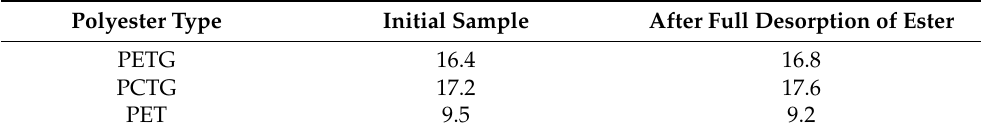
Table 2. Melt flow index of polyester samples at 260 °C, 2.16 kg.